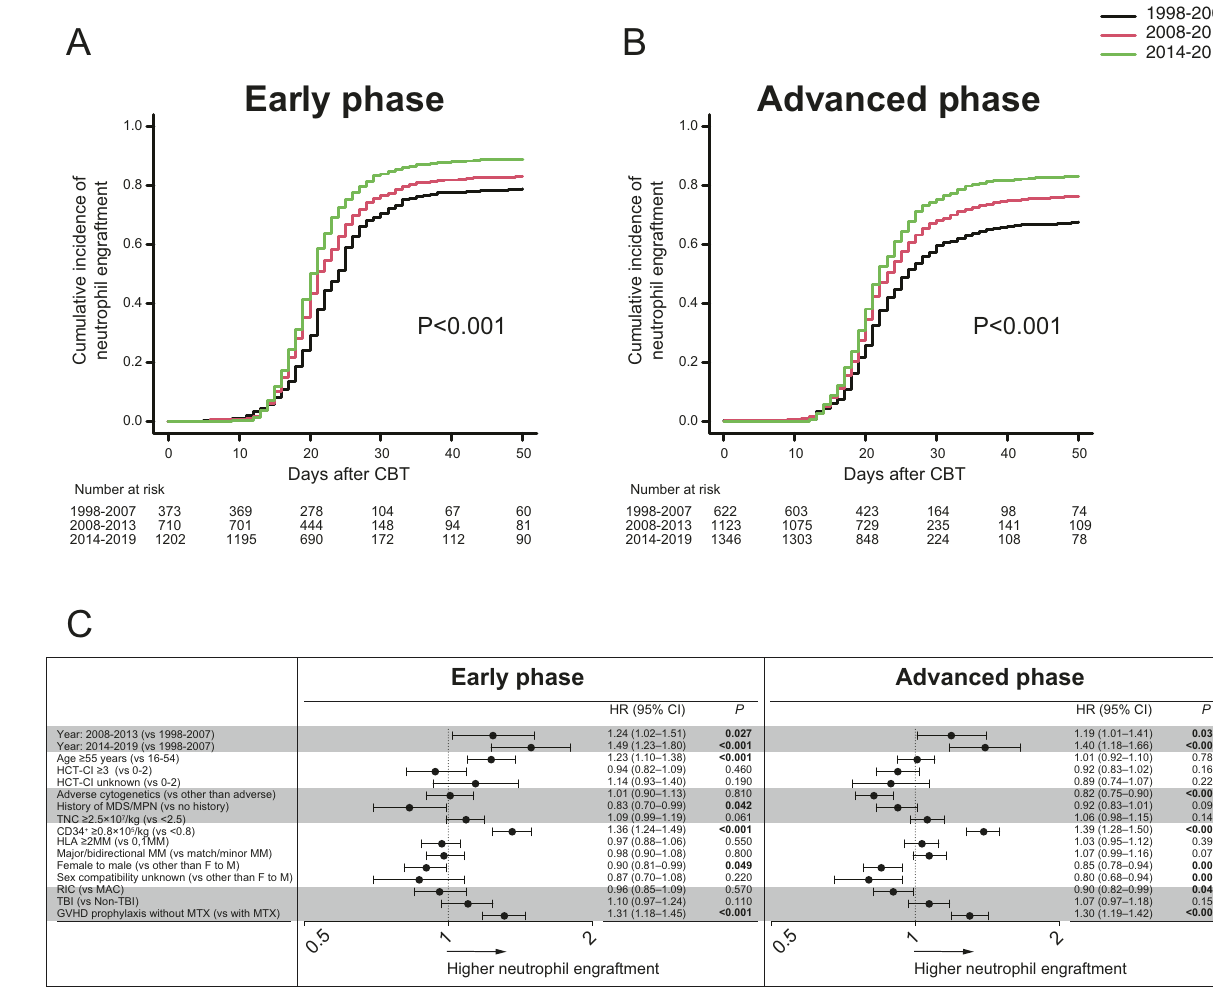
Fig. 5 Neutrophil engraftment after CBT according to disease status at CBT. The cumulative incidences of neutrophil engraftment after CBT according to the three time periods in patients with early phase at CBT ( A ), or advanced phase at CBT ( B ). Forest plots of the adjusted hazard ratios (HR) and 95% con fi dence intervals (CI) of neutrophil engraftment among each cohort in the multivariate analysis ( C conditioning regimens, and more careful cord blood graft selection, along with higher achievements of neutrophil engraft- ment, could have contributed to the improvement of NRM. Importantly, the improvement of NRM was observed in the recent time period (2014 – 2019) but only among patients with remission status at CBT. This indicates that the improved NRM can be attributed mainly to the prevention, diagnosis, and management of infection, organ toxicity, and GVHD after CBT. The most important limitation of CBT for adults is that the frequency of primary graft failure is higher after CBT compared with allogeneic HCT from adult donors [4]. Although the achievements of neutrophil engraftment after CBT could not completely attain the levels of those after allogeneic HCT from adult donors, trends of neutrophil engraftment were improved over time throughout all cohorts. The reasons for these trends in neutrophil engraftment are not entirely clear but could be attributed to the recent progress of a higher TNC and CD34 + cell dose in the cryopreserved cord blood unit [11]. This is partly due to improvements of collection and processing techniques of cryopreserved cord blood by cell processing technicians and obstetricians. Moreover, the presence of anti-HLA antibodies, particularly DSA, has mostly been evaluated before selection of a cord blood unit in recent time periods to avoid engraftment failure [8, 34]. Indeed, only 56 patients had DSA in the entire our